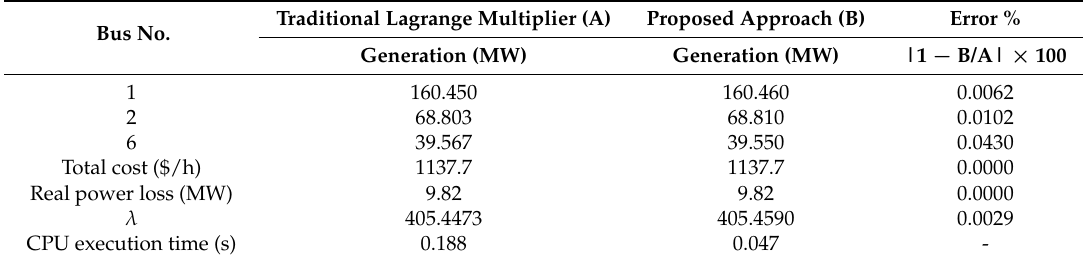
Table 1. Comparison of the simulation results of the traditional Lagrange multiplier method and the proposed approach for the ED of the original IEEE 14-bus test